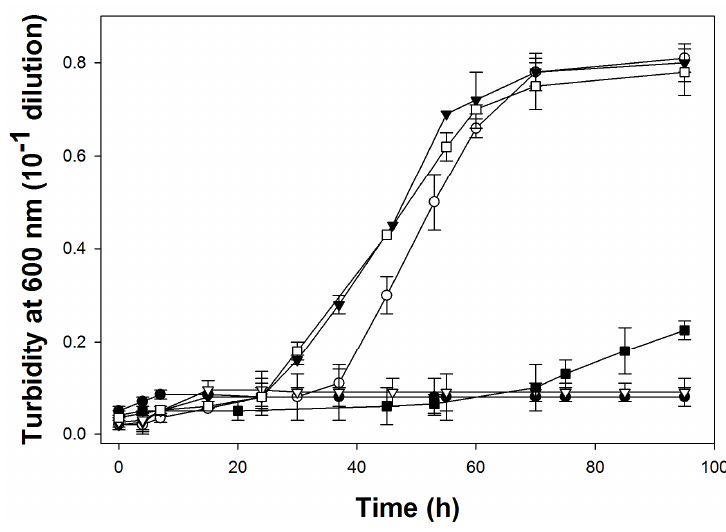
FIGURE 4. Growth of each mutant strain on benzene as the sole carbon source — M1 ( (cid:1) ), M2b ( (cid:2) ), M2c ( (cid:1) ), M3 ( (cid:2) ), M5b ( (cid:3) ), M6b ( (cid:4) ). Where SD error bars are not shown, it is because they were smaller than the